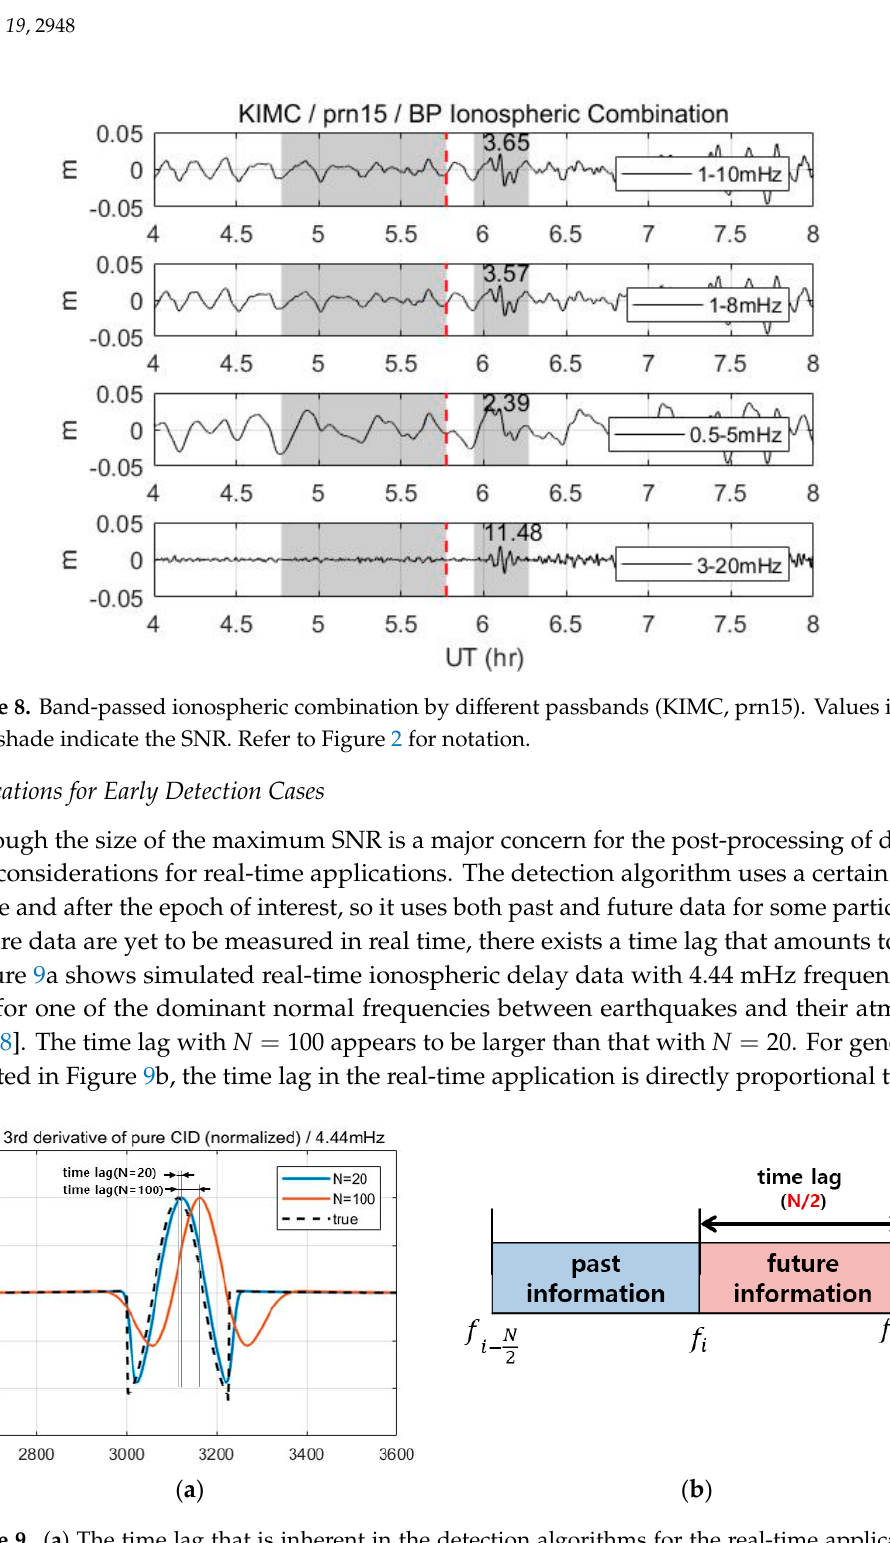
Figure 9. ( a ) The time lag that is inherent in the detection algorithms for the real-time application, and ( b ) its